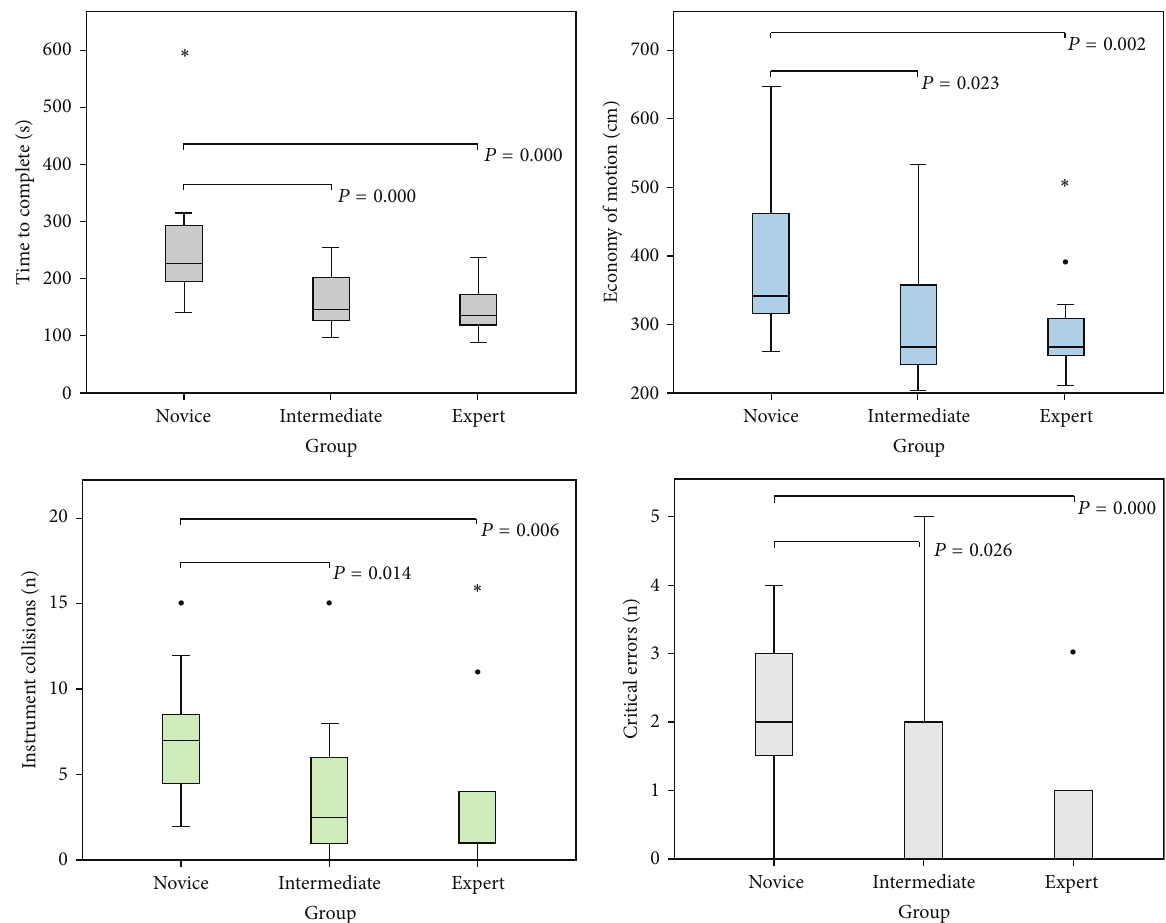
Figure 4: Exercise “Thread the Rings” (box plot of the four most important parameters in the exercise (bars are medians, boxes show inter quartile range, whiskers show range, ∙ are outliers, ∗ are extreme outliers, and large horizontal bars indicate statistically significant differences, specified with 𝑃